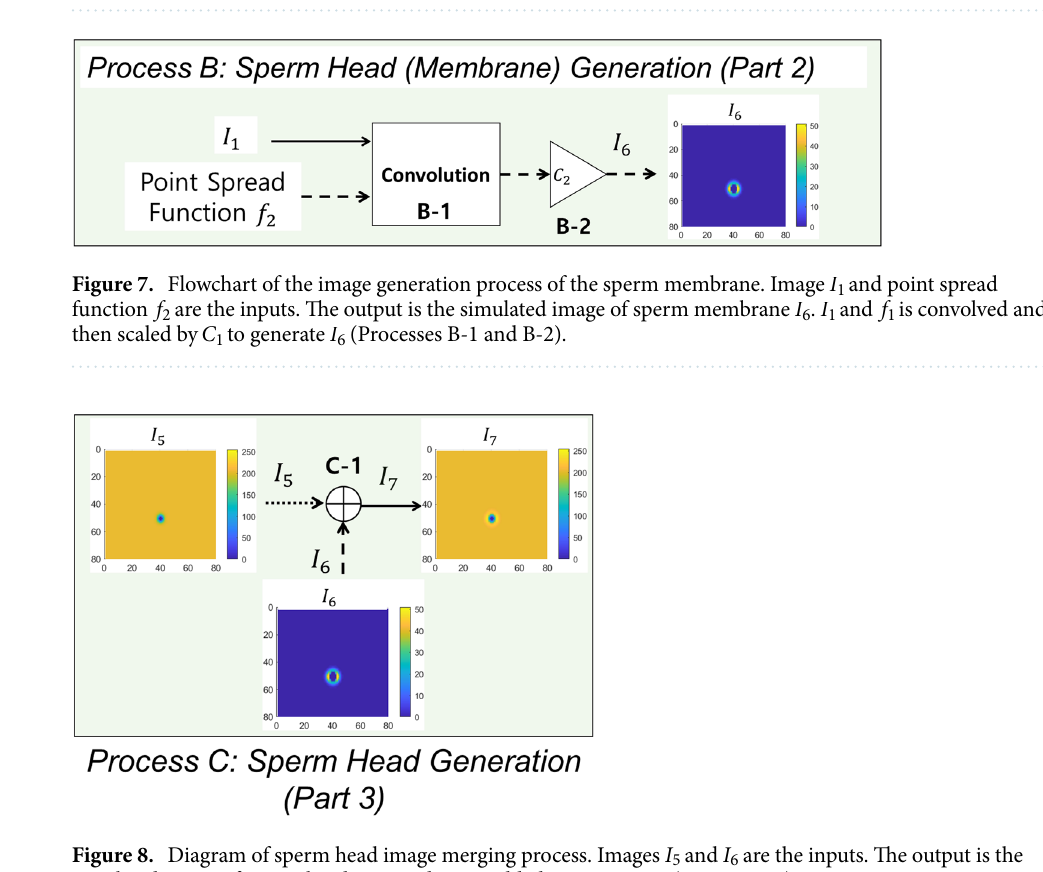
Figure 6. Point spread functions used in sperm cell image generation process; ( a ) f 1 , ( b ) f 2 , ( c ) f 3 .